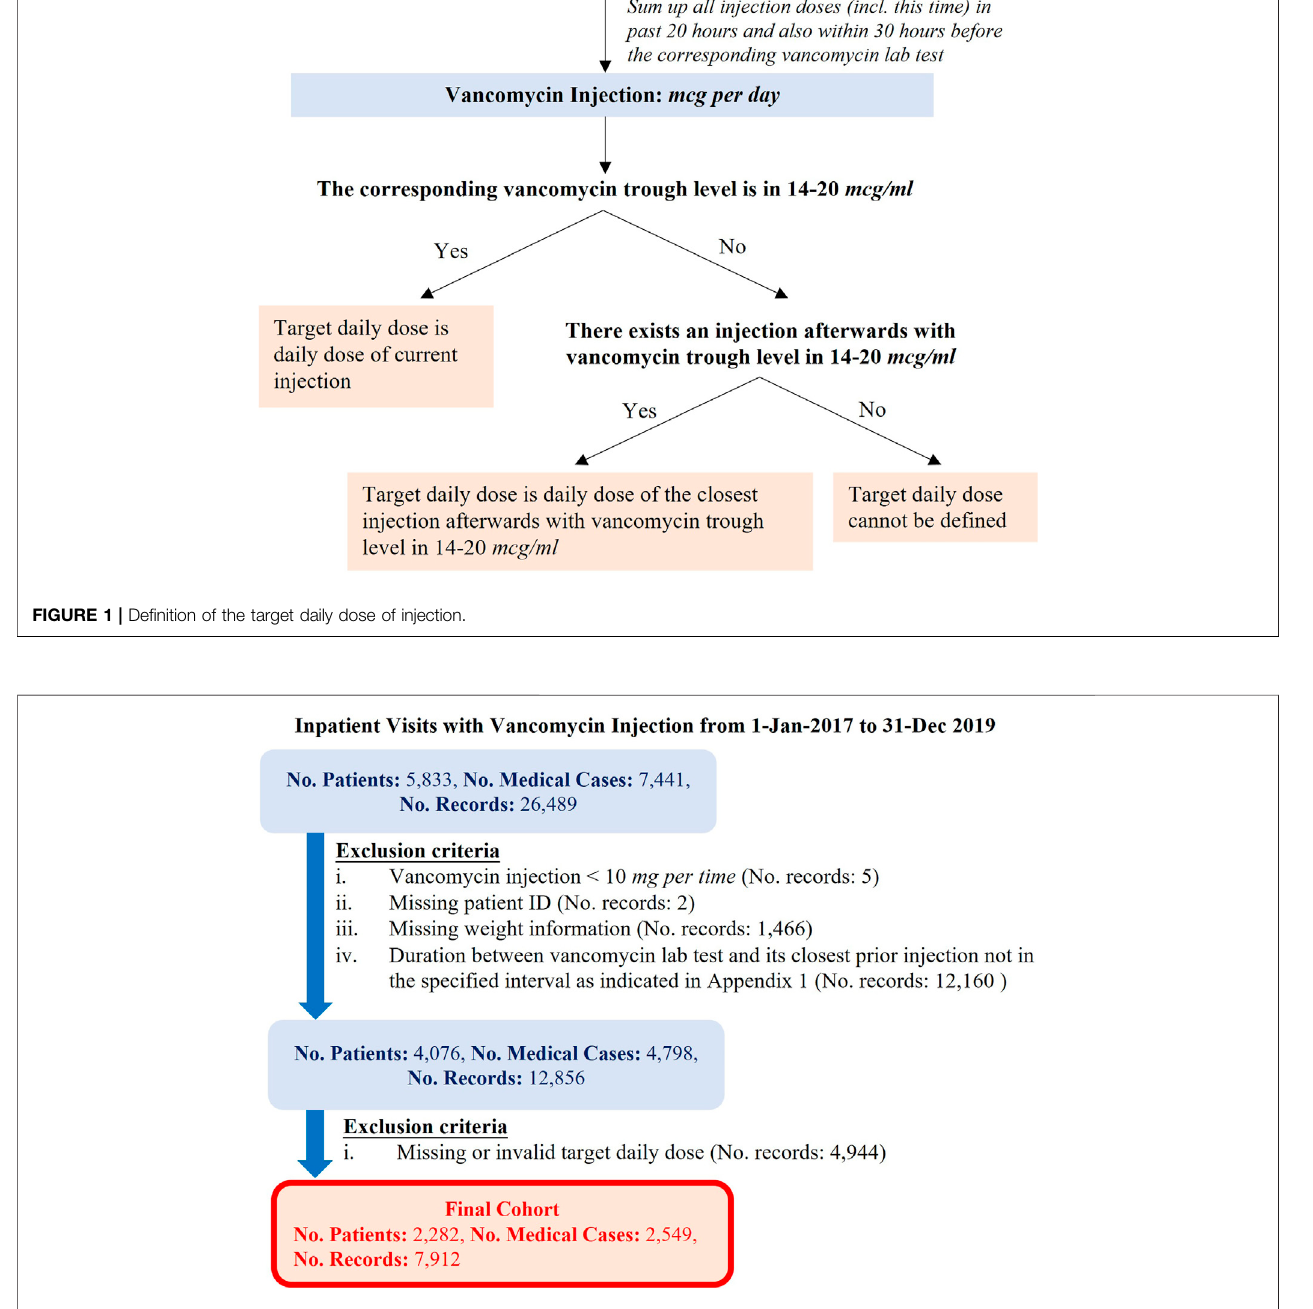
FIGURE 2 | De fi nition of the cohort in the